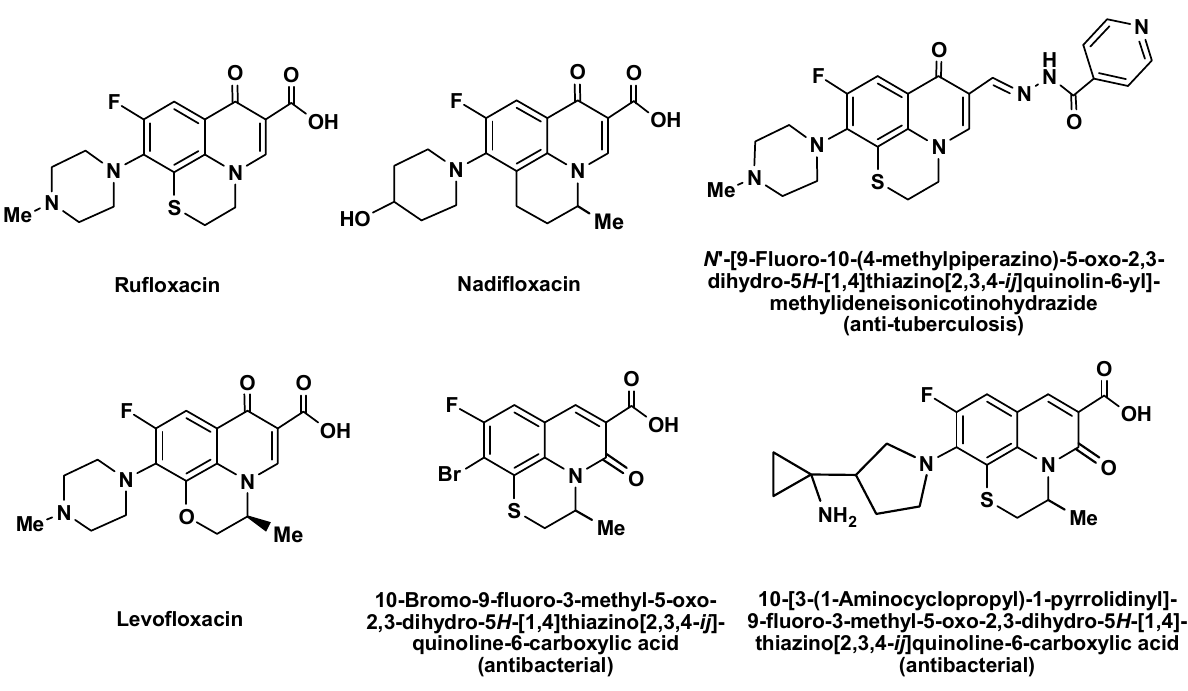
10-[3-(1-Aminocyclopropyl)-1-pyrrolidinyl]- 9-fluoro-3-methyl-5-oxo-2,3-dihydro-5 H -[1,4]- thiazino[2,3,4- ij ]quinoline-6-carboxylic acid (antibacterial) Figure 1. Known biologically active tricyclic quinoline compounds structurally related to the 2 H ,3 H -[1,4]thiazino[2,3,4- ij ]quinolin-4-ium scaffold (fluoroquinolone antibiotics [1–5], compounds with antibacterial [19] and anti-tuberculosis [20] activity). The development of a method for the efficient regioselective synthesis of novel heterocyclic and condensed organochalcogen compounds by cyclization and annulation reactions of chalcogen reagents is the focus of our research [21–34]. Recently we described the annulation reactions of 8-pyridinesulfenyl halides with functionalized alkenes and cycloalkenes affording a series of 2 H ,3 H -[1,4]thiazino[2,3,4- ij ]quinolin-4-ium derivatives in high yields [33,34]. For example, the annulation reactions with divinyl and vinyl phenyl sulfides proceeded with the attachment of the sulfur atom of 8-pyridinesulfenyl halides at the β -position of the vinylsulfanyl group, while the addition of the sulfur atom occurred at the α -carbon atom of the vinylsilyl moiety in the case of tetravinyl silane with the formation of 2-(trivinylsilyl)-2 H ,3 H -[1,4]thiazino[2,3,4- ij ]quinolin-4-ium chloride ( 1 ) (Scheme 1).